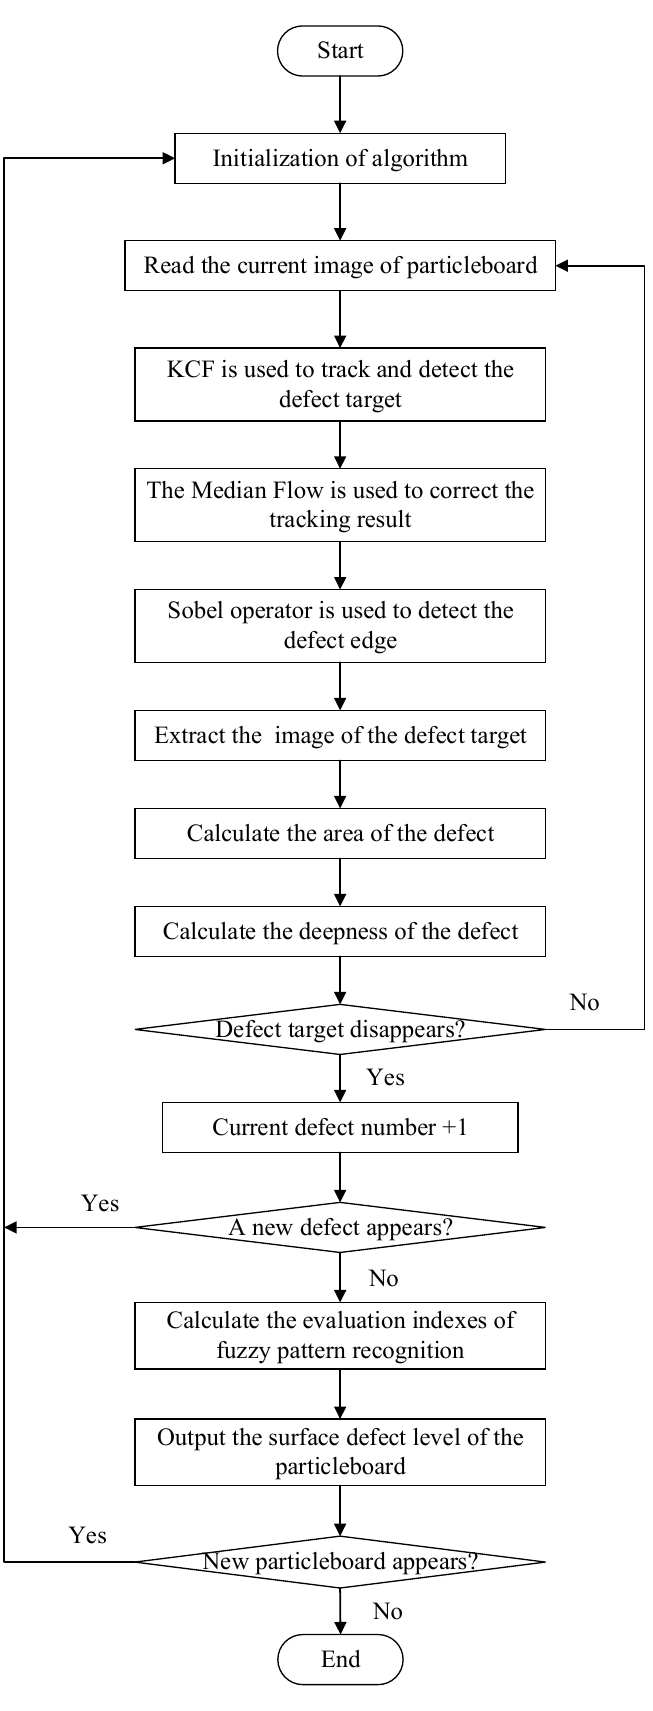
Figure 7. Flowchart of the detection of surface defects in particleboards and surface quality evaluation.